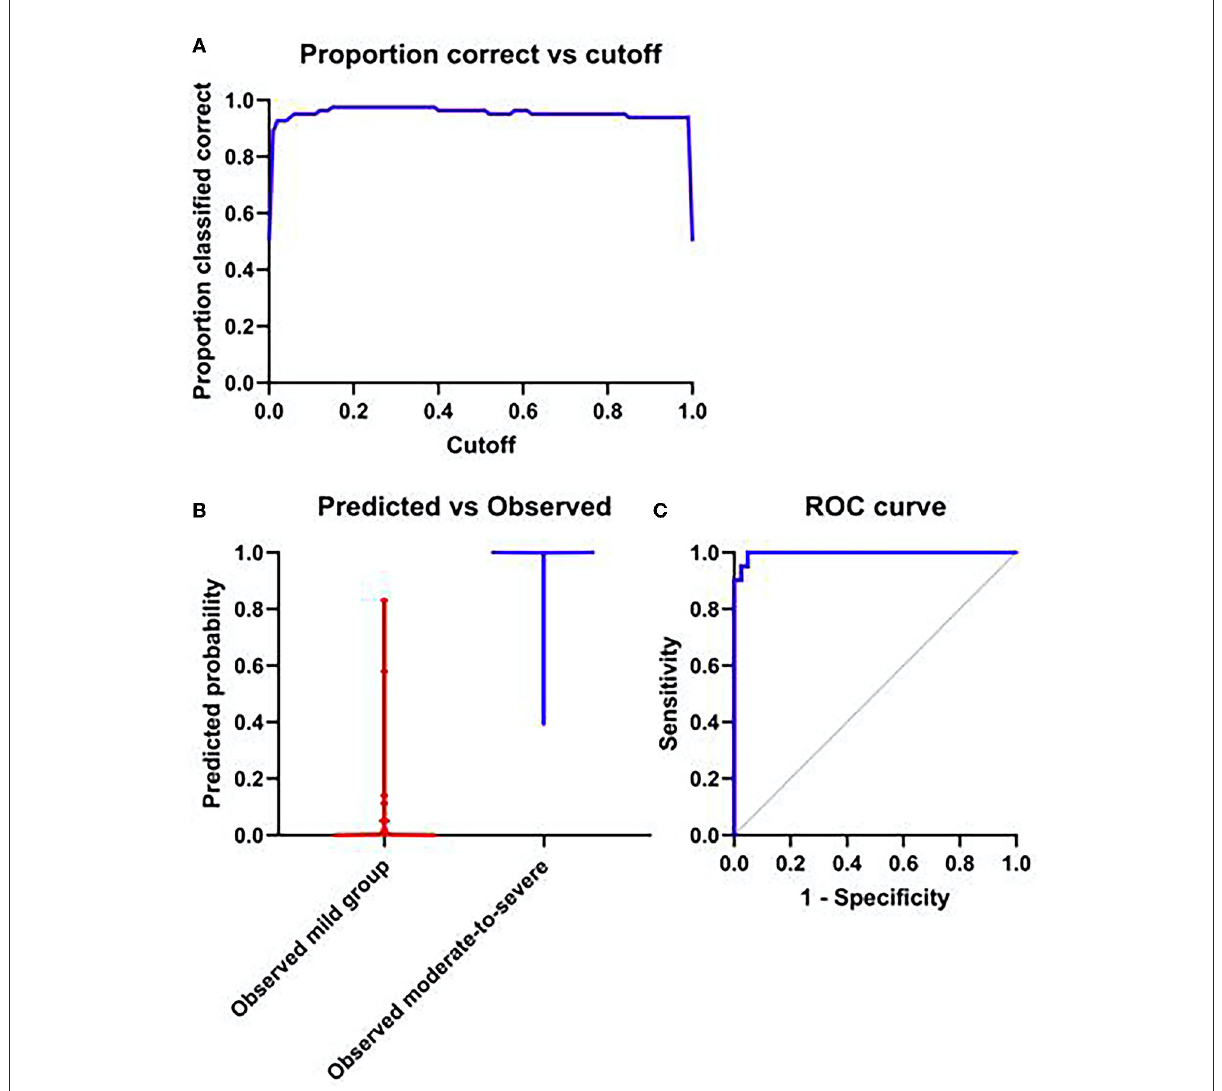
FIGURE6 (A) The probability of accurate prediction changes with different prediction thresholds. (B) Forecast probability and measured individual. (C) ROC curve of model; AUC =